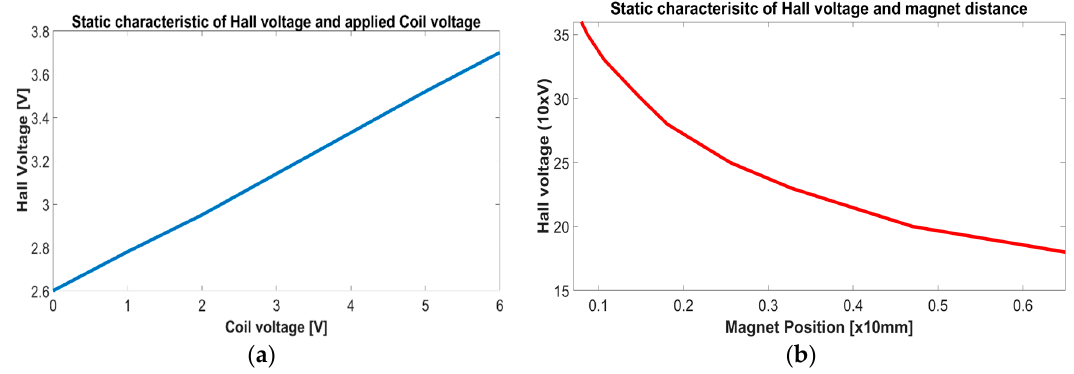
Figure 11. Static characteristics of Hall voltage in regard to applied coil voltage—( a ) and the magnet proximity—( b ).